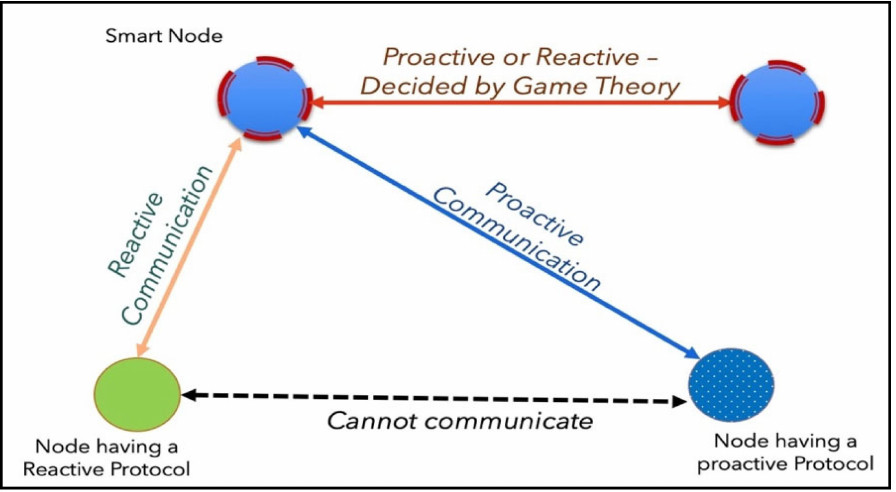
Figure 1. Proposed types of nodes and the in-between communication